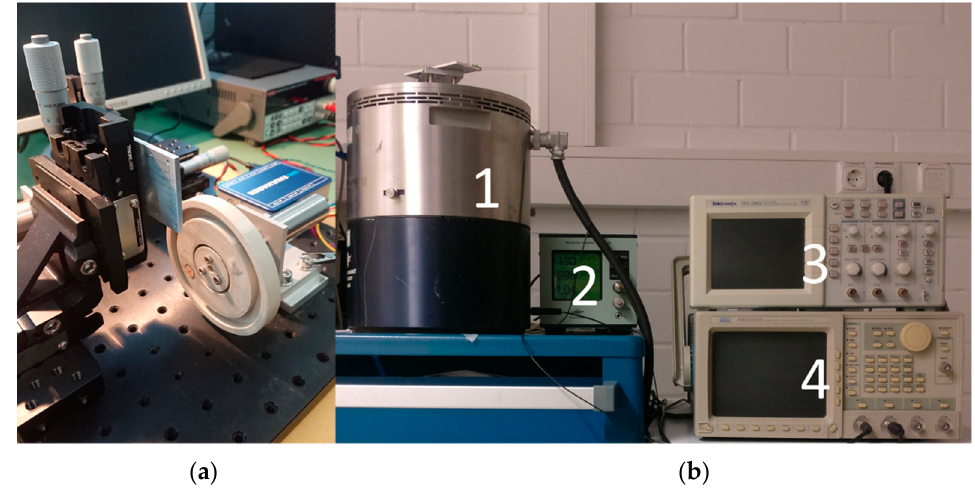
Figure 9. ( a ) Photograph of the measurement setup for magnetic excitation with pole wheel, motor and stage. The photograph in ( b ) presents an overview of the shaker setup with high displacement head (1), charge amplifier (2), oscilloscope (3) and frequency generator (4). The core components of this setup are as follows: Exciter body (Brüel & Kjær Type 4805, Nærum, Denmark), high displacement head power amplifier (Brüel & Kjær Type 2707), charge amplifier (Brüel & Kjær Type 2525), reference accelerometer sensor